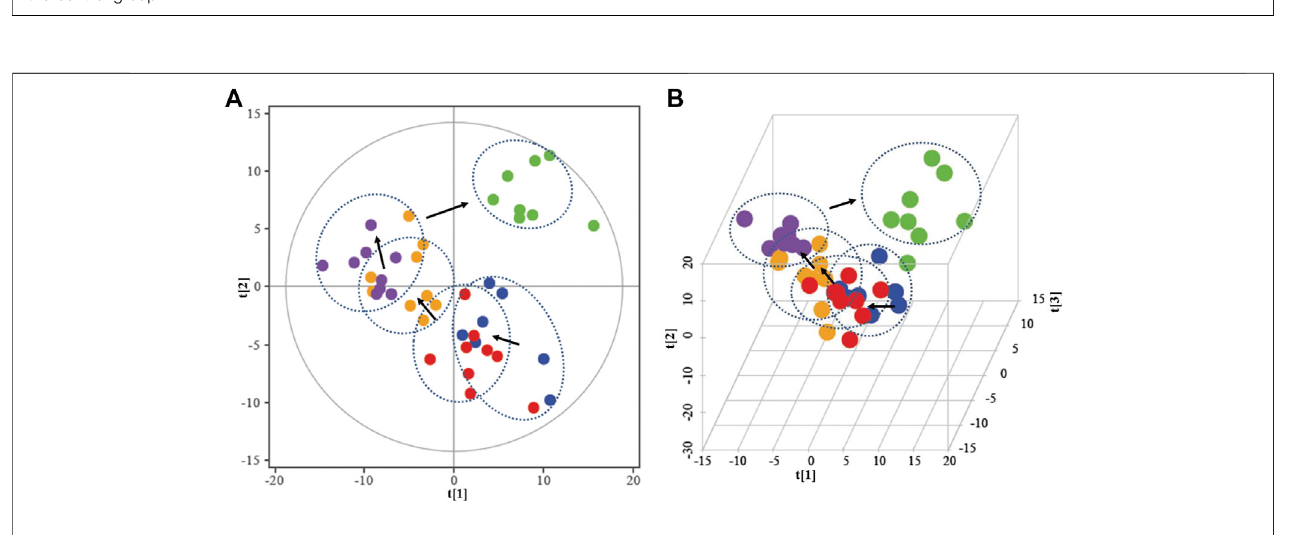
FIGURE4 | 2D-PLS-DA (A) and 3D-PLS-DA (B) score map in all groups. in green indicates in the control group; In blue indicates inthe model group; in red indicates in the PNS group; in yellow indicates in the ASA group; in purple indicates in the combined use